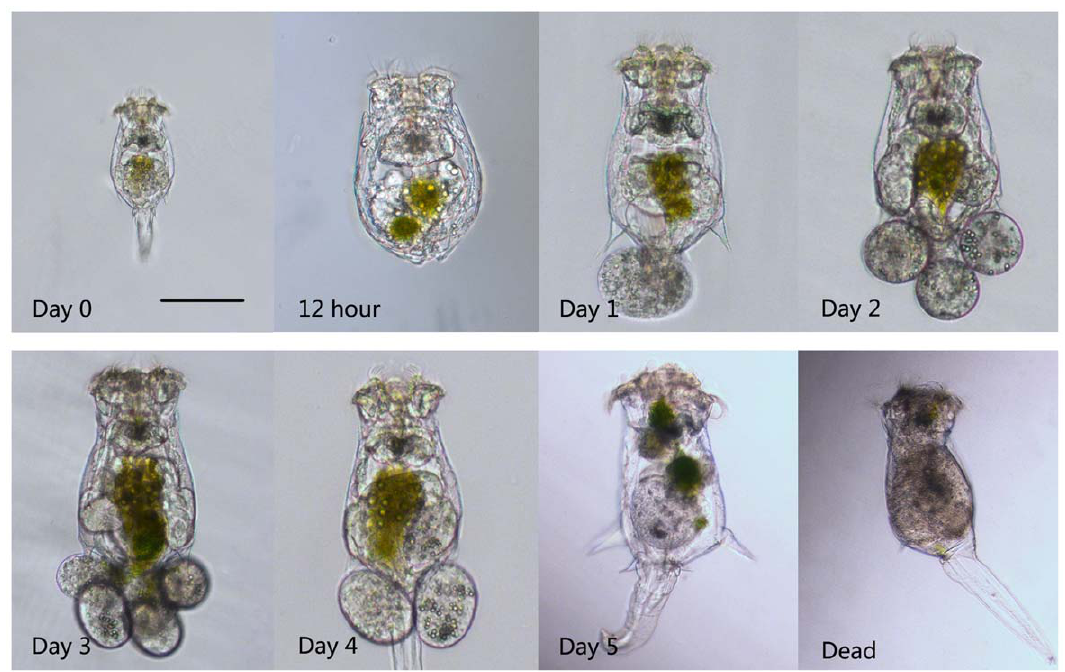
Figure 2. Photomicrographs of female rotifers of various ages.